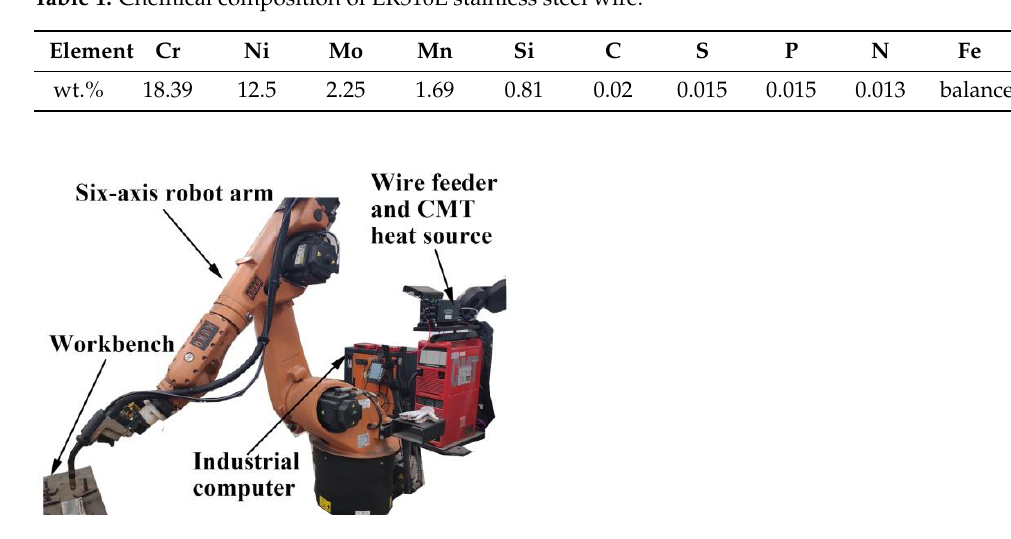
Figure 1. Cold metal transfer (CMT)-based wire arc additive manufacturing (WAAM) system.